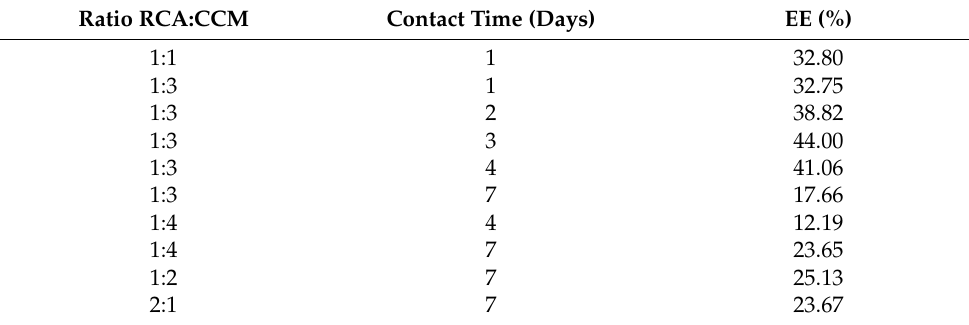
Table 3. Tests to evaluate encapsulation efficiency.